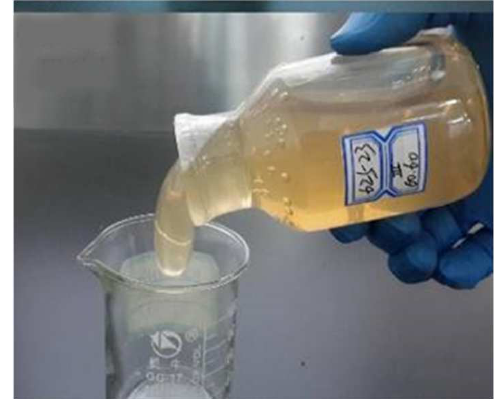
Table 15. Polyacrylamide parameters in CBG.